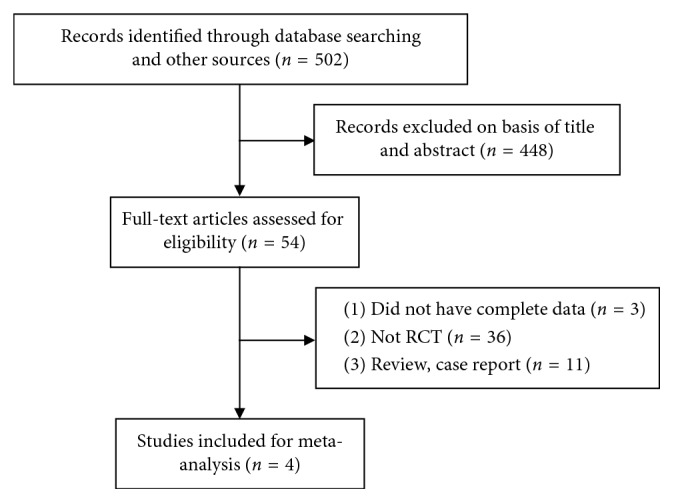
Flow diagram of the literature search in this meta-analysis.